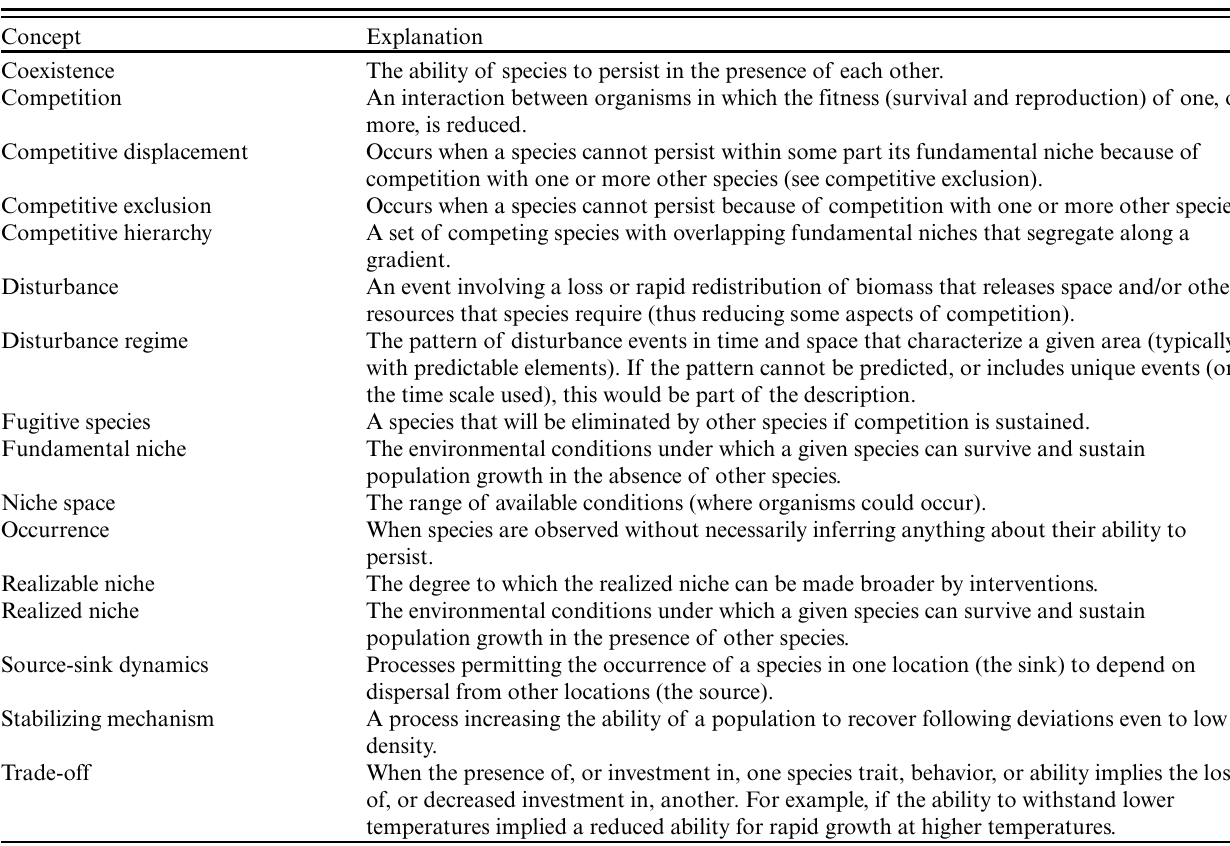
Table 1 . Glossary of concepts used in the main